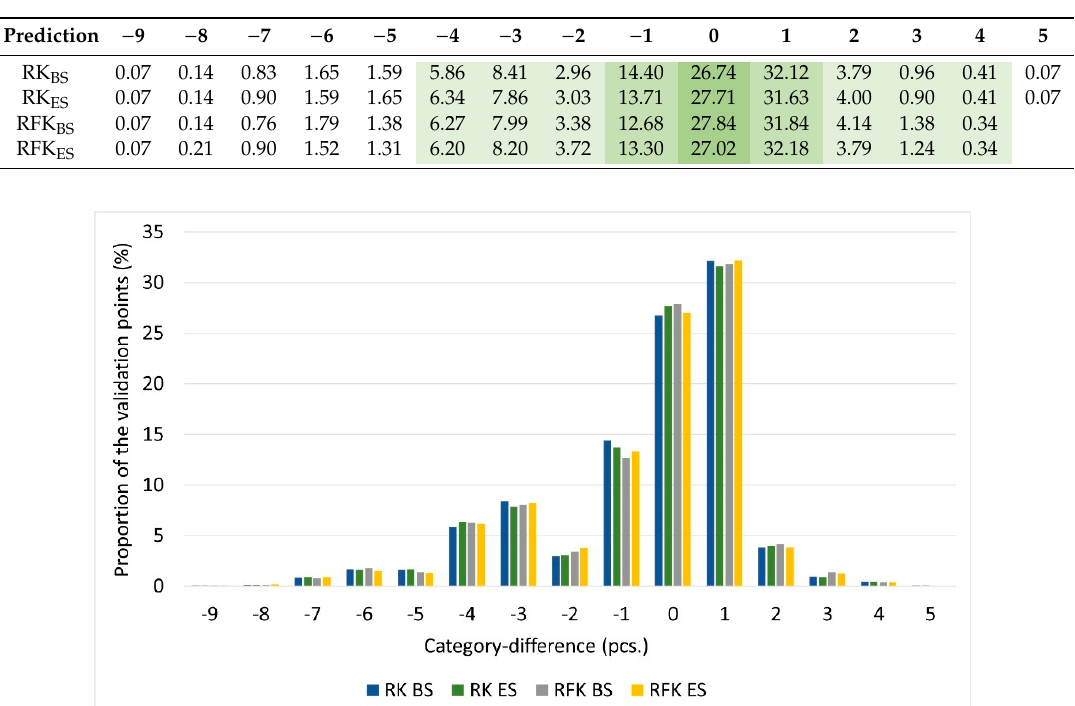
Table 2. Category-di ff erence between the independent validation dataset, and the categorized predicted values expressed in percentage.